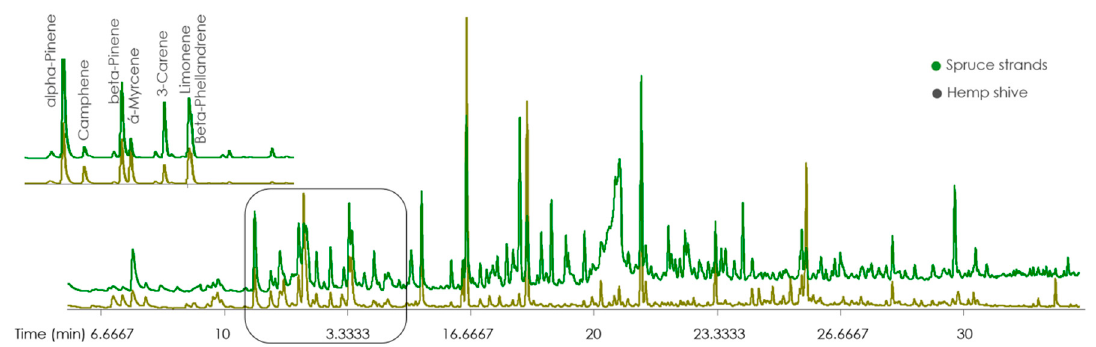
Figure 4. Chromatograms of VOCs extracted from spruce strands and hemp shives (with a focus on terpenes).